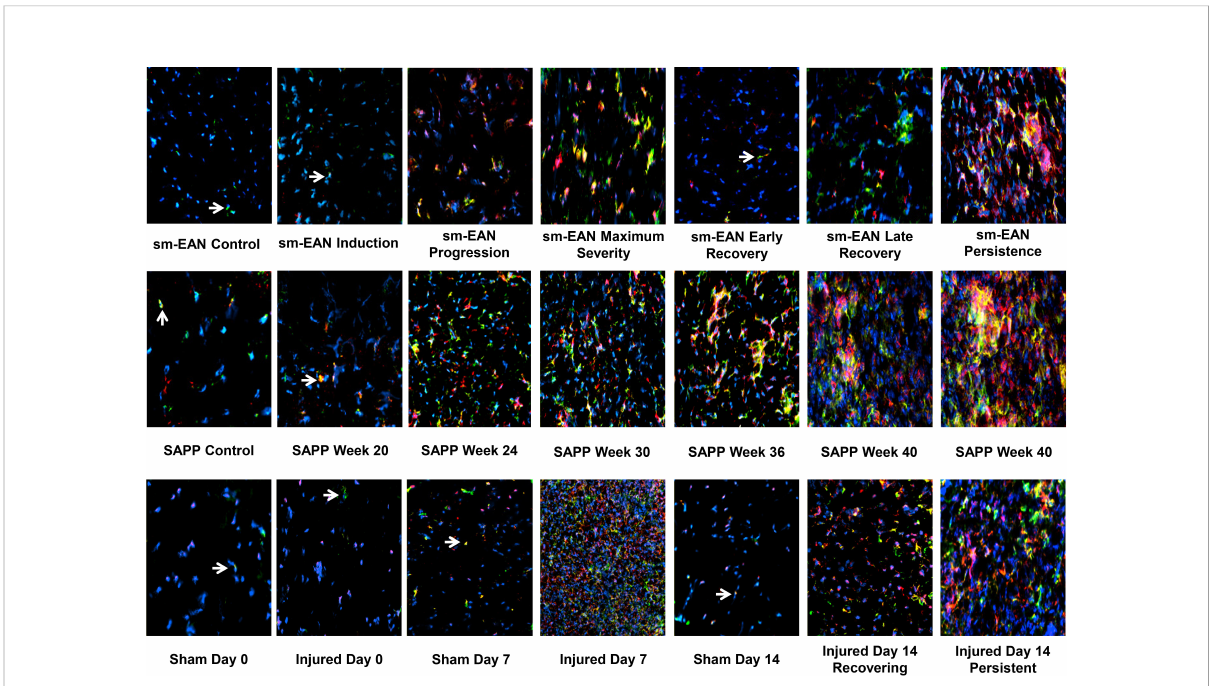
FIGURE 4 Sciatic nerve CD11b+ CD45+ leukocyte in fi ltration in mouse in fl ammatory and traumatic neuropathy models. Representative digital axial photomicrographs of mouse sciatic nerves show rare positive-staining leukocytes (white arrows) in sm-EAN, SAPP, and Sham surgery control nerves. These cells are also rarely seen in sm-EAN mice during early recovery and on day 0 in crush injured sciatic nerves. In fi ltration of CD11b+ CD45+ leukocytes (yellow and orange colors) is associated with motor disease progression/severity and persistent axonal degeneration in these adult mouse in fl ammatory and traumatic peripheral neuropathy models. Blue (DAPI) depicts nuclei. Original magni fi cation 200-400X. N =